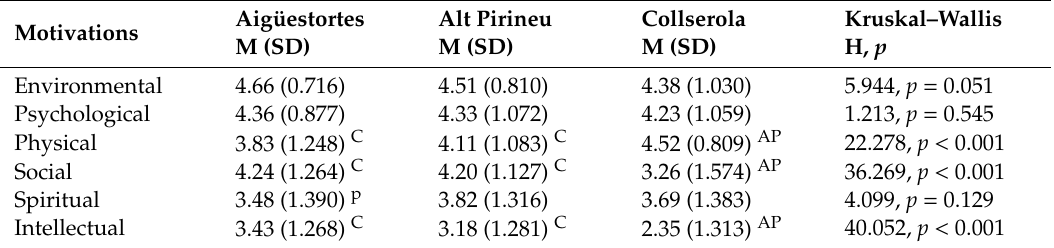
Table 5. Visitors’ health and well-being motivations. Descriptive statistics and comparisons between